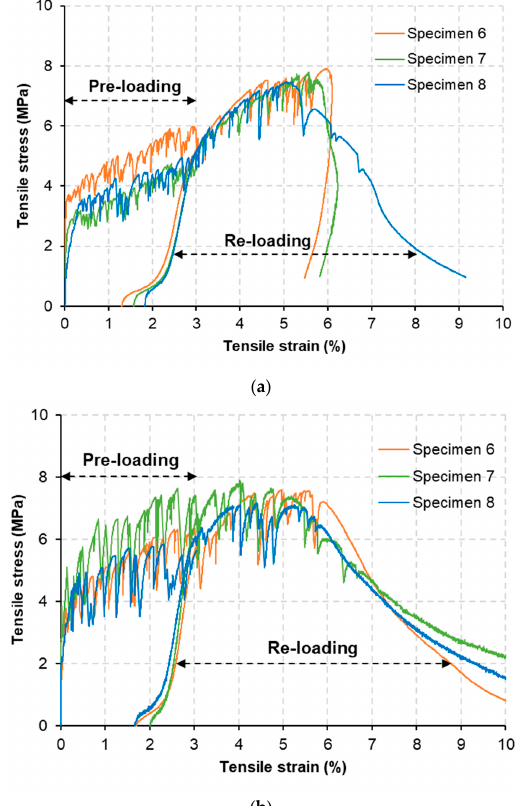
Figure 10. Tensile stress–strain curves at post-healing of: ( a ) M-W and ( b ) M-O mixtures. Table 7. Tensile strength and tensile strain capacity at post-healing. Mixture